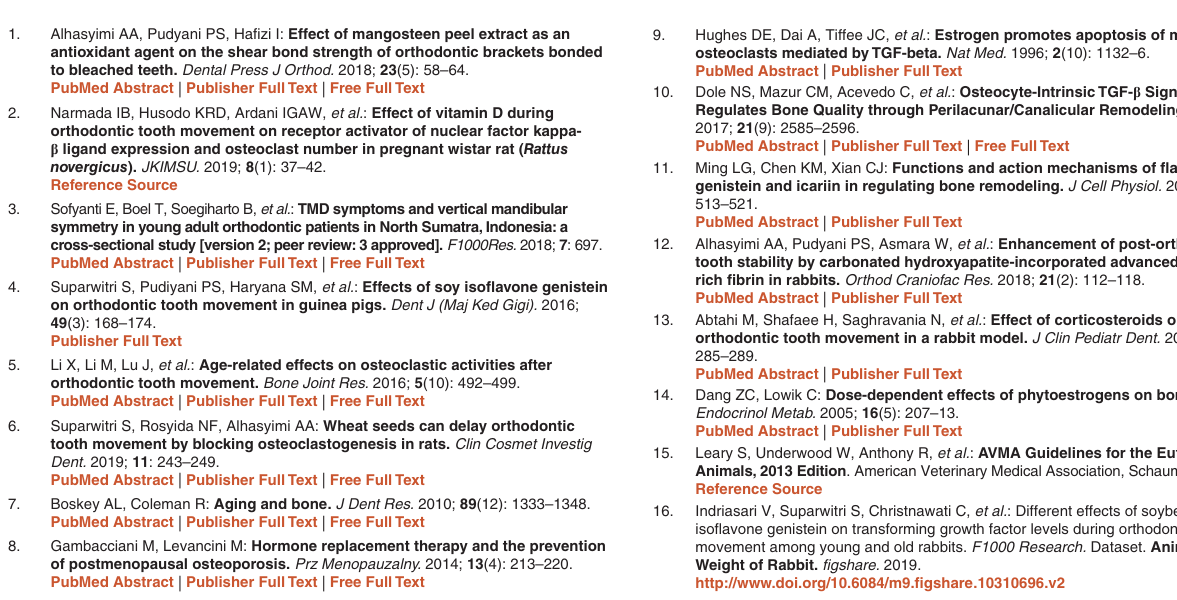
- Animal Body Weight.xlsx (Animal body